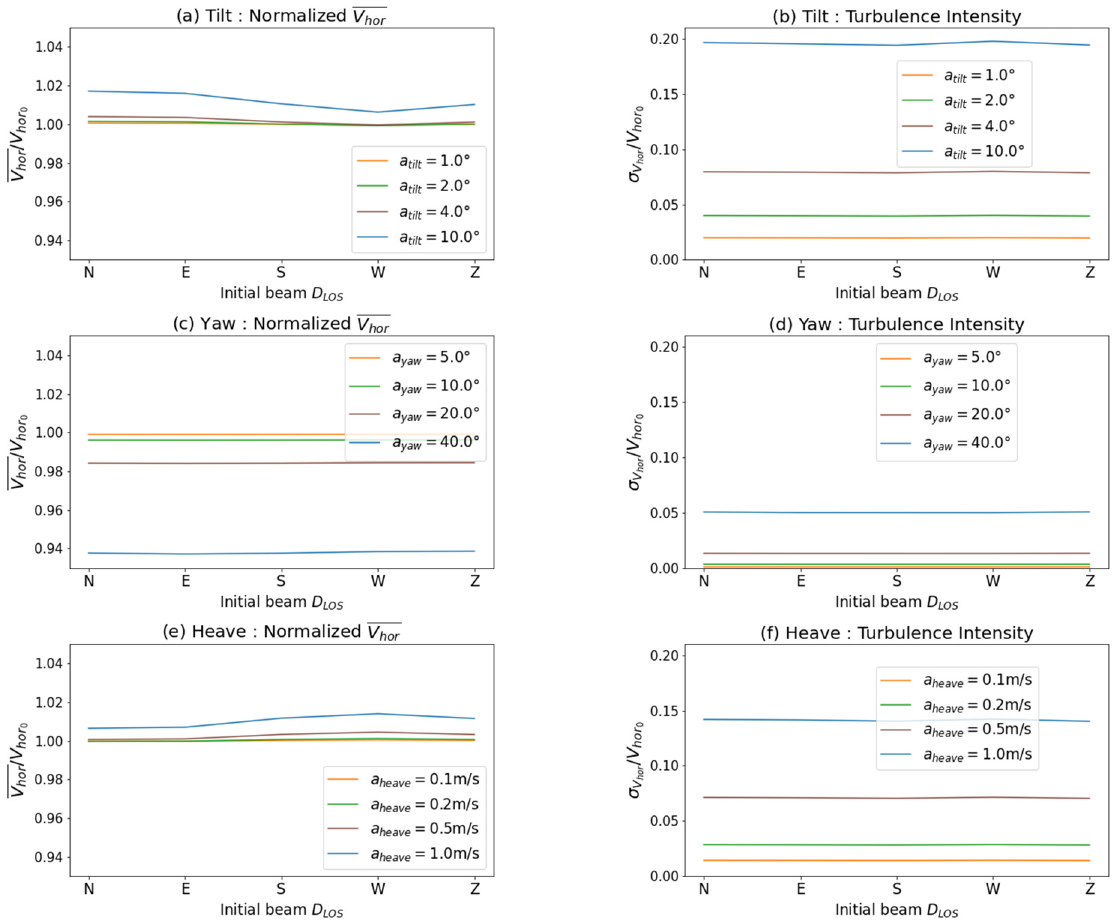
Figure 11. Influence of direction of the initial beam within the model on the mean horizontal wind speed and its standard deviation estimated by the model and normalized by the incident horizontal speed V hor sinusoidal tilting motion of period P tilt = 4 s for an incident wind along the component perpendicular to the rotation axis. ( c , d ) LIDAR subjected to a sinusoidal yaw motion of period P yaw = 3 s. ( e , f ) LIDAR subjected to a sinusoidal heave motion of period P heave = 4